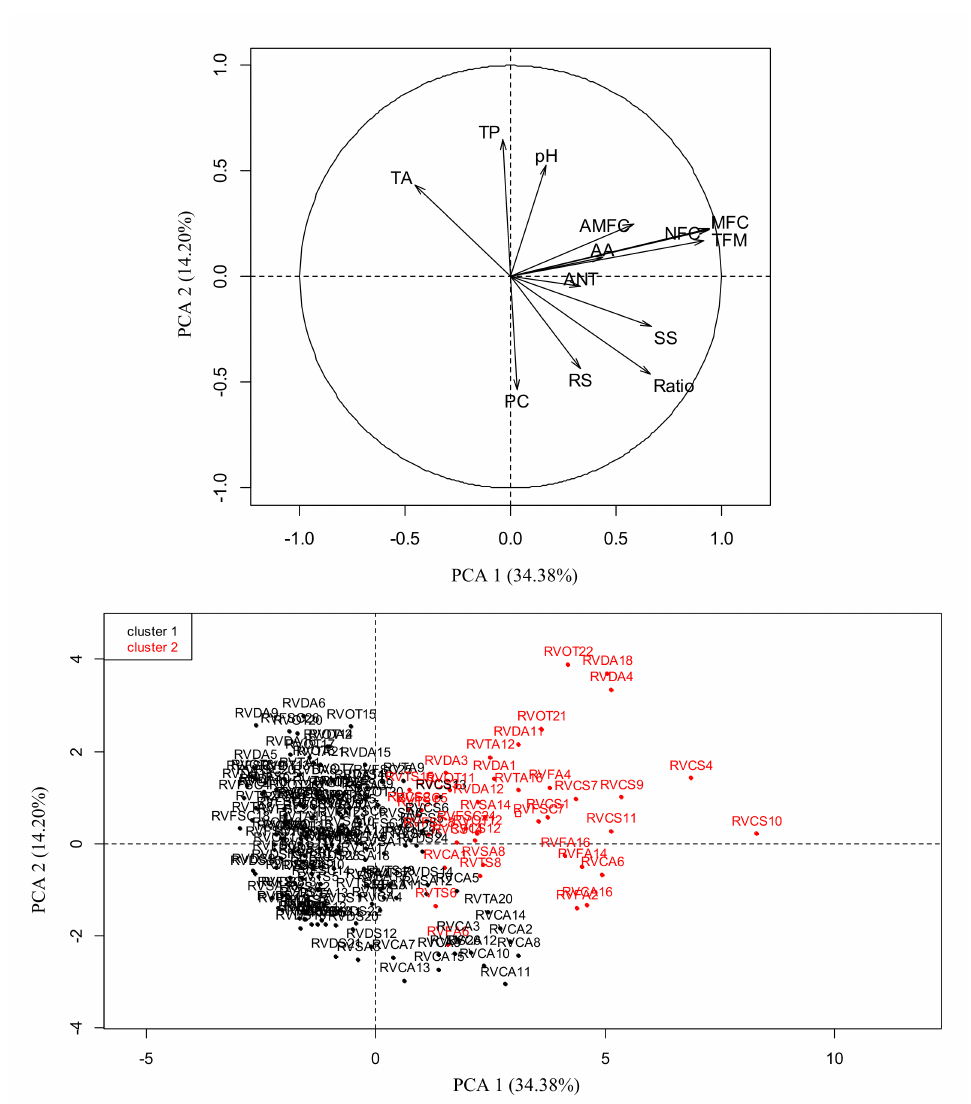
Figure 5. Principal component analysis between agronomic, physicochemical, and bioactive compound traits obtained from di ff erent Fragaria × ananassa Duchesne ex Rozierhybrids. NCF: Number of Commercial Fruits (fruits / plant), AMCF: Average Mass of Commercial Fruits (g / fruit), MCF: Mass of Commercial Fruits (g / plant1), TFM: Total Fruit Mass (g / plant), SS: Soluble Solids (Brix), TA: Titratable acidity (g citric acid 100 g − 1 pulp), SS / TA Ratio: Soluble Solids / Titratable Acidity, RS: Reducing Sugar (%), PC: Phenolic Compounds (mg galic acid 100 g − 1 pulp), TP: Total Pectin (g total pectin 100 g − 1 pulp), AA: Ascorbic Acid (mg ascorbic acid 100 g − 1 pulp) and ANT: Anthocyanins (mg pelargonidin-3-glycoside 100 g − 1